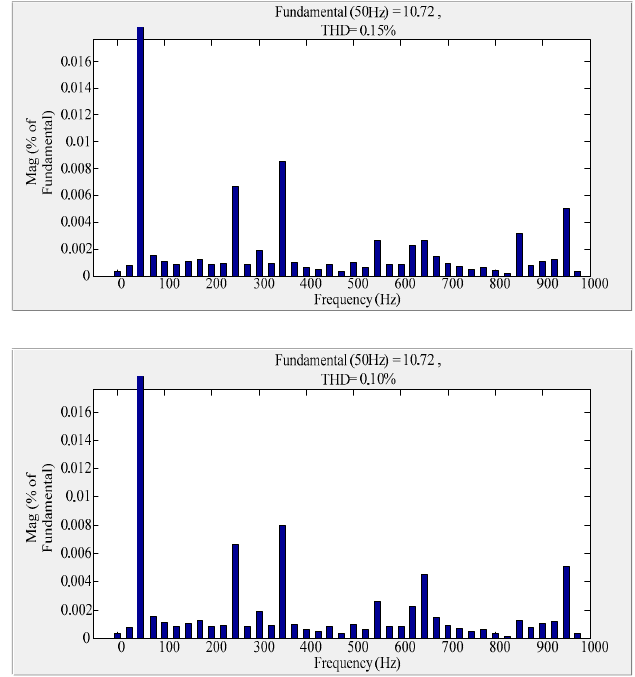
Figure 17. The influence of adjusting the weight factor of the capacitor voltage.